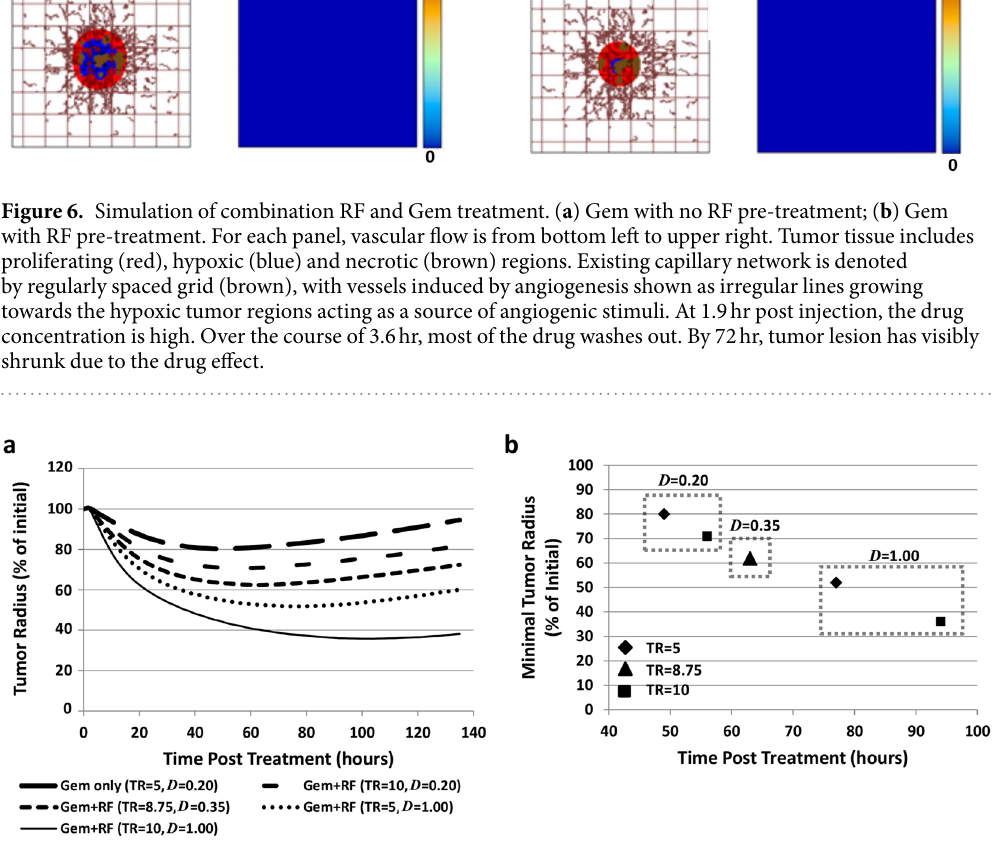
Figure 7. Analysis of treatment simulations. ( a ) Change in simulated tumor lesion radius based on different therapy scenarios. ( b ) Minimal tumor size achieved for each simulated treatment. Dotted boxes enclose cases with like diffusive penetration. A trend of minimal size decreasing in time emerges, which highlights the relative contribution to regression of RF modulation of drug diffusive penetration and vascular extravasation transfer rate. Middle (triangle) indicates Gem penetration and transfer rate increasing by 75% following non-invasive RF exposure (calibrated from experimental data). TR: drug vascular extravasation transfer rate (for O 2 , TR = 5); D : drug diffusive penetration (for O 2 , D =